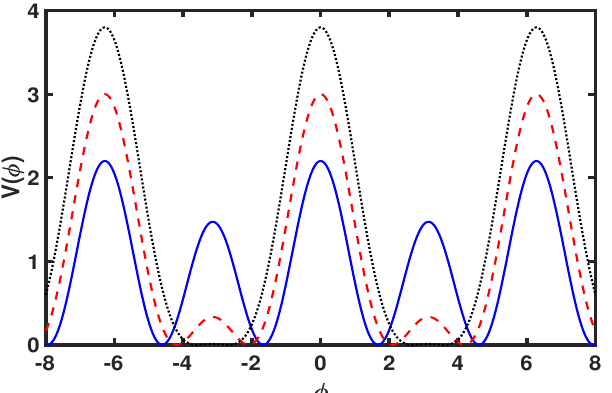
Figure 1 . Potential V ( φ ) given by the eq. (2.3). It is fixed r = 0 . 1 (blue solid), r = 0 . 5 (red dash), r = 0 . 9 (black